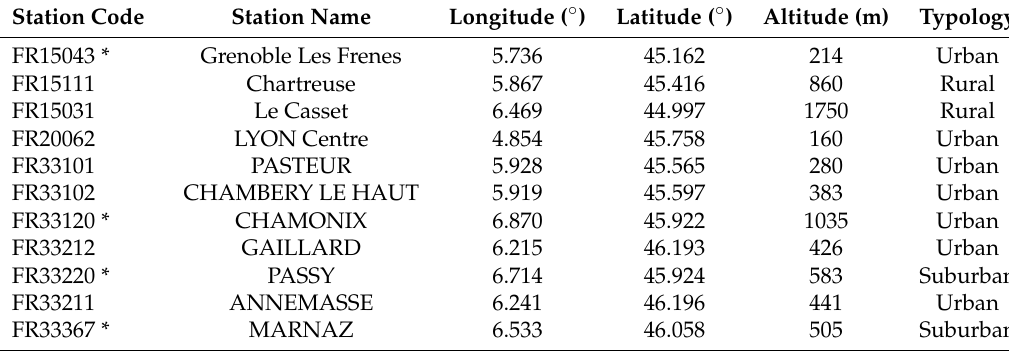
Table 4. List and location of the main air quality monitoring stations (PM10, PM2.5, NO, NO 2 , O 3 ,